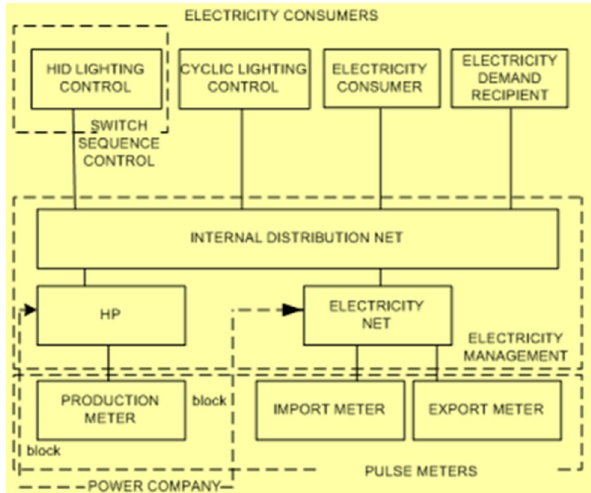
Figure A2. General structure of the production and distribution of electricity.